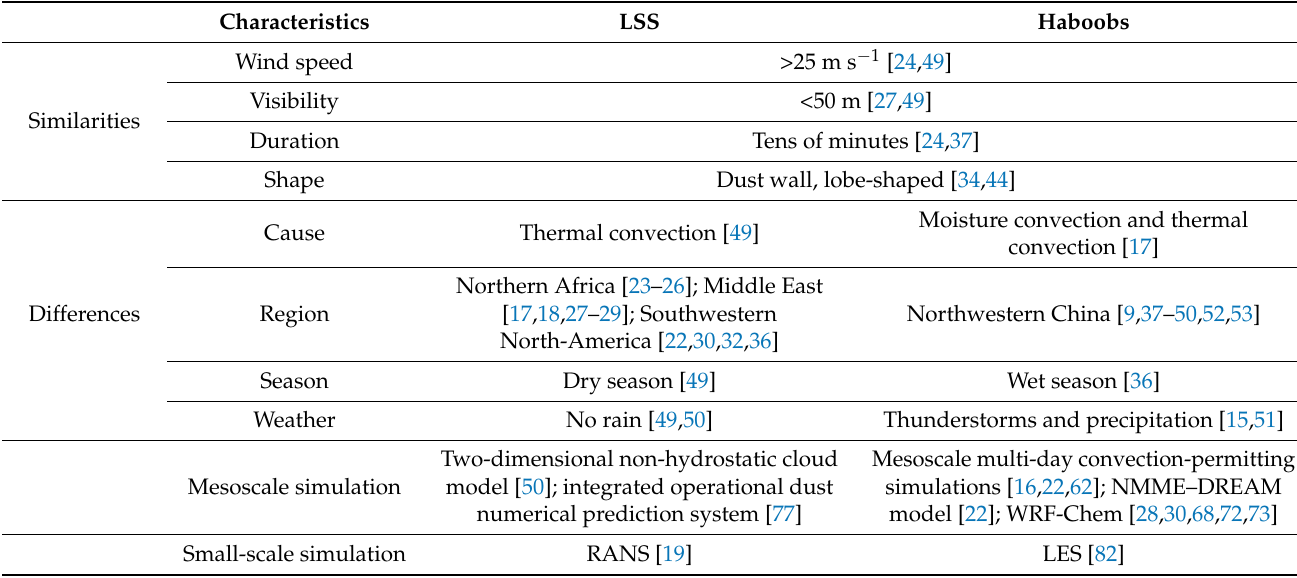
Table A1. Comparison of LSS and